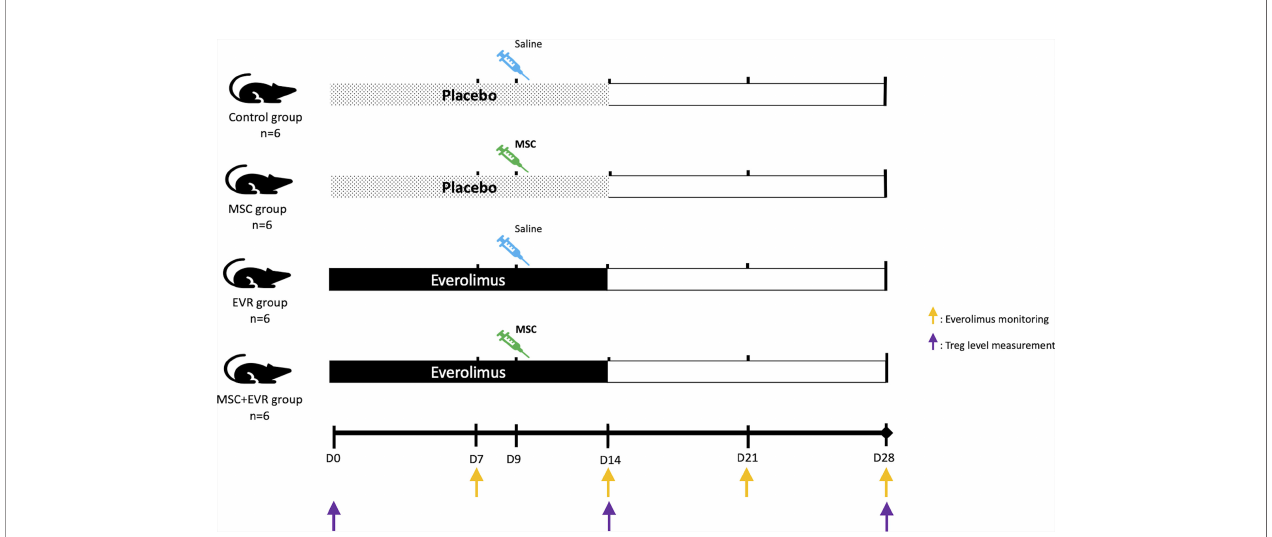
FIGURE 1 | Evaluation of the effect of MSCs and everolimus on Treg proliferation (experimental design). Pumps were implanted at D0 and functioned for 14 days. One injection of MSCs or saline was performed at D9. Everolimus blood levels were monitored once a week (orange arrows); Treg blood levels were measured by fl ow cytometry on D0, D14 and D28 (purple arrows). D, day; EVR, everolimus; MSC, mesenchymal stromal cell; Treg, regulatory T